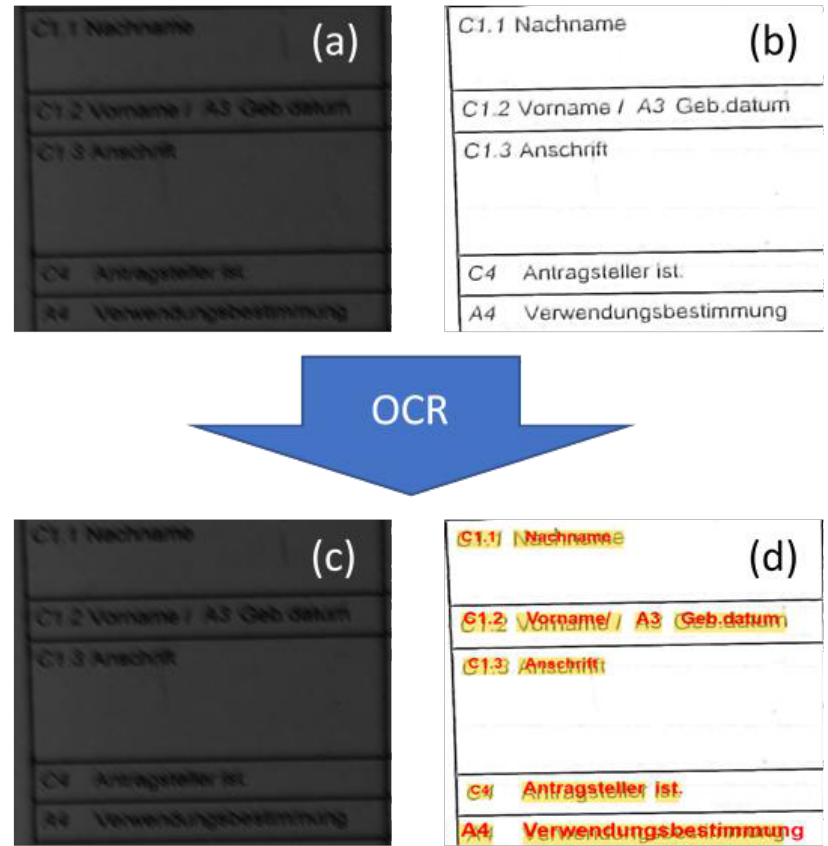
Figure 12. Effect of blind enhancement on OCR text detection (using our global model consisting of Module 1 + Module 2). Image ( a ) shows the original image. Image ( b ) shows the blind enhanced image of Image ( a ). Image ( c ) shows the detected texts through Tesseract OCR software [73] (no text is marked). Image ( d ) shows the detected texts marked with yellow. The recognized texts are shown by red text.